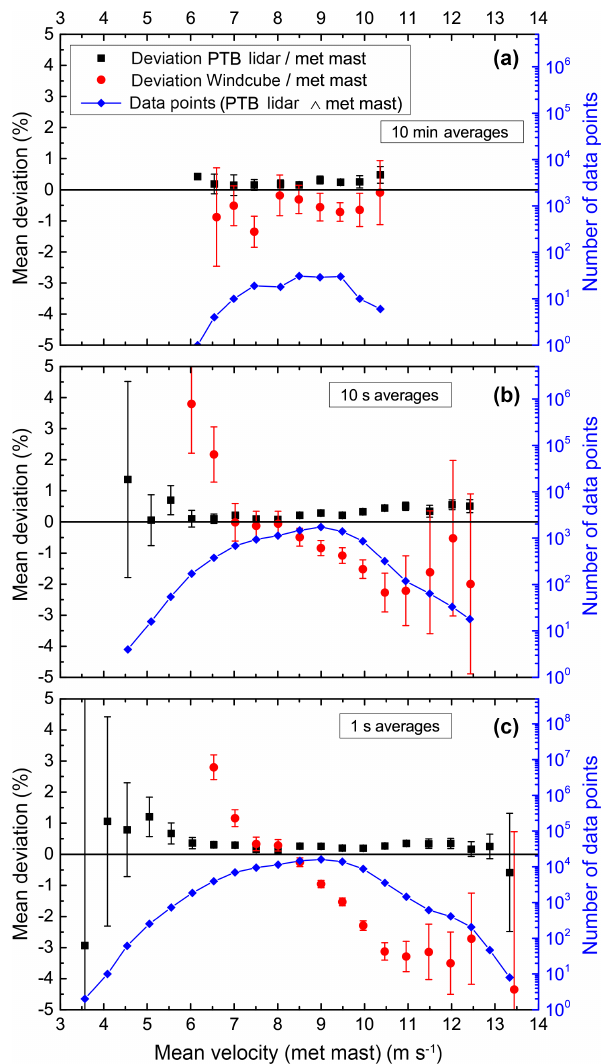
Figure 7. Comparison of PTB lidar (black squares) and Windcube (red points) with decreasing temporal averaging (a) – (c) for undis- turbed wind conditions (campaign 2). The blue diamonds are the number of data points of the PTB lidar (equivalent: the wind met mast) available in each velocity slot (the lines guide the eye).